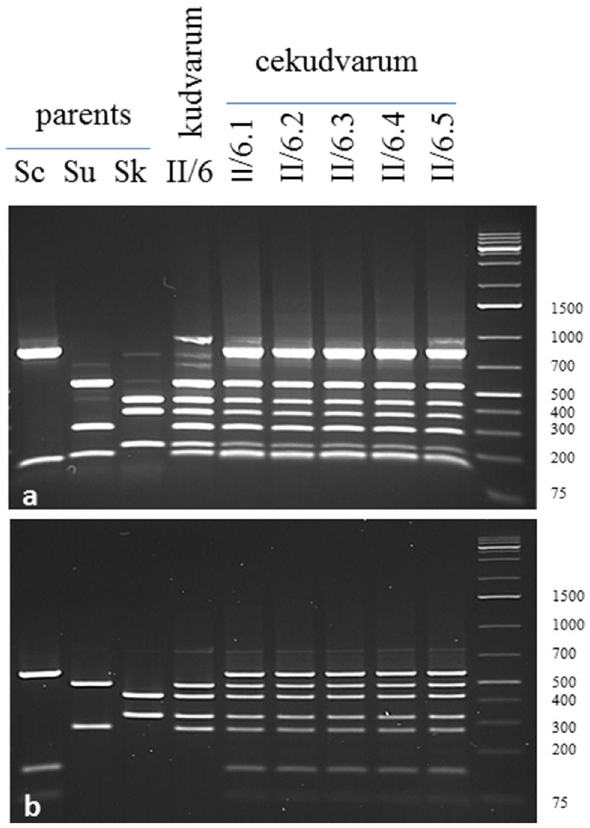
Figure 3. Examples of PCR–RFLP restriction patterns. ( a ) MNT2 digested with Msp I. ( b ) RDR1 digested with Hae III. Sc: 10–170 S. cerevisiae . Su: 10–1651 S. uvarum . Sk: 1653 S. kudriavzevii . MNT2 is located on Chr VII Sc , Chr 7 Sk and Chr 5 Su . RDR1 is located on Chr XV Sc , Chr 15 Sk and Chr 8 Su . Size ladder on the right